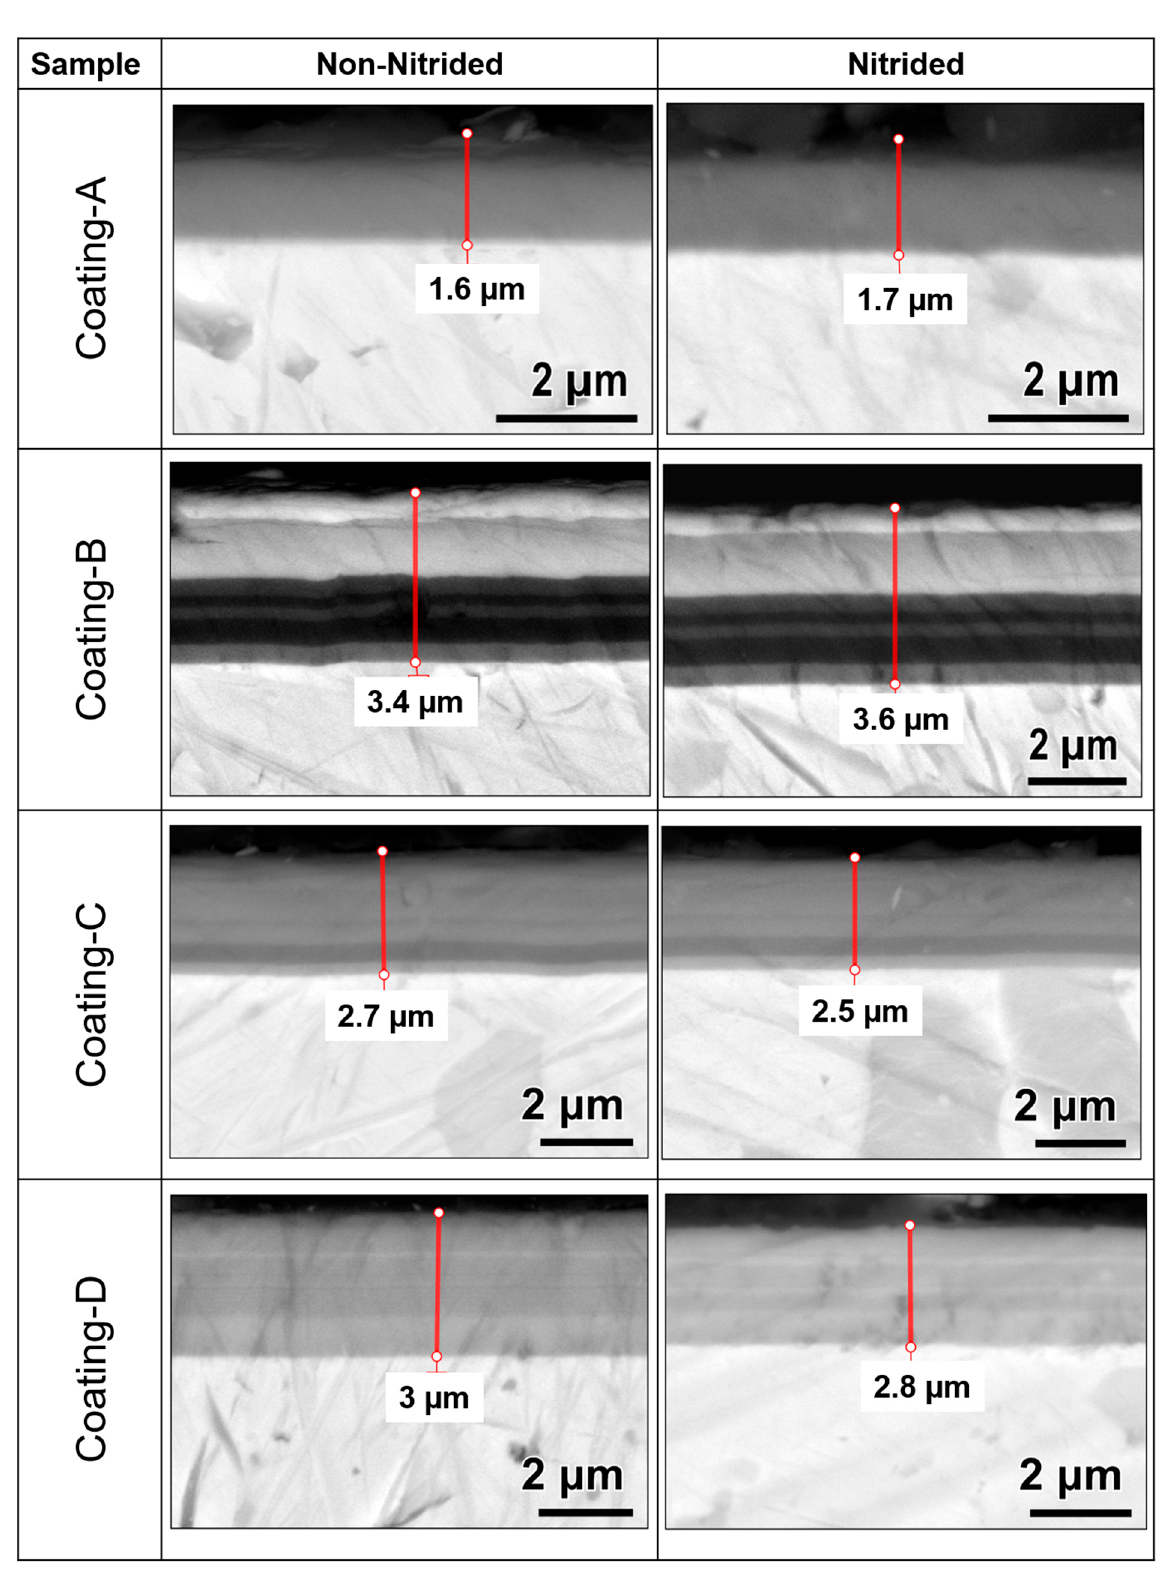
Figure 5. SEM cross-section images of the coatings.